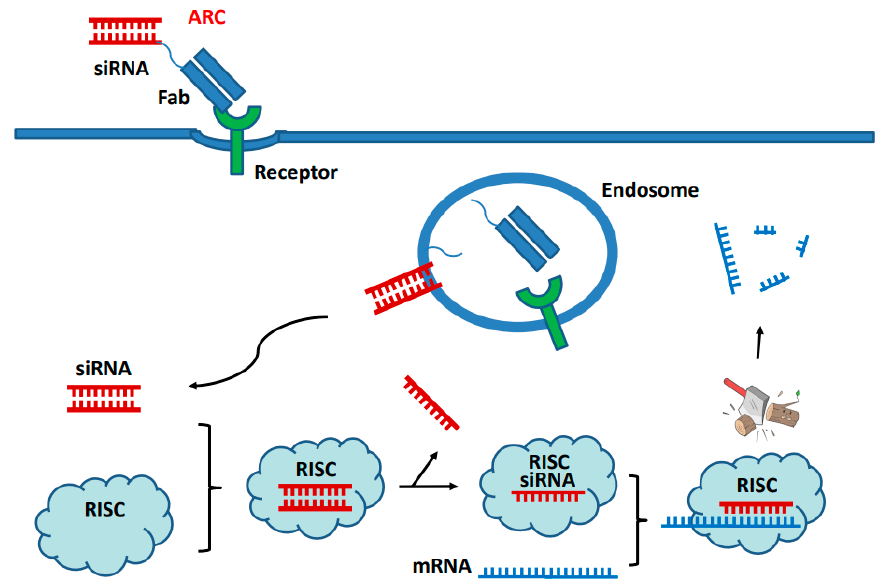
Figure 3. The mechanism of action of antibody conjugated with short interfering RNA (siRNA).